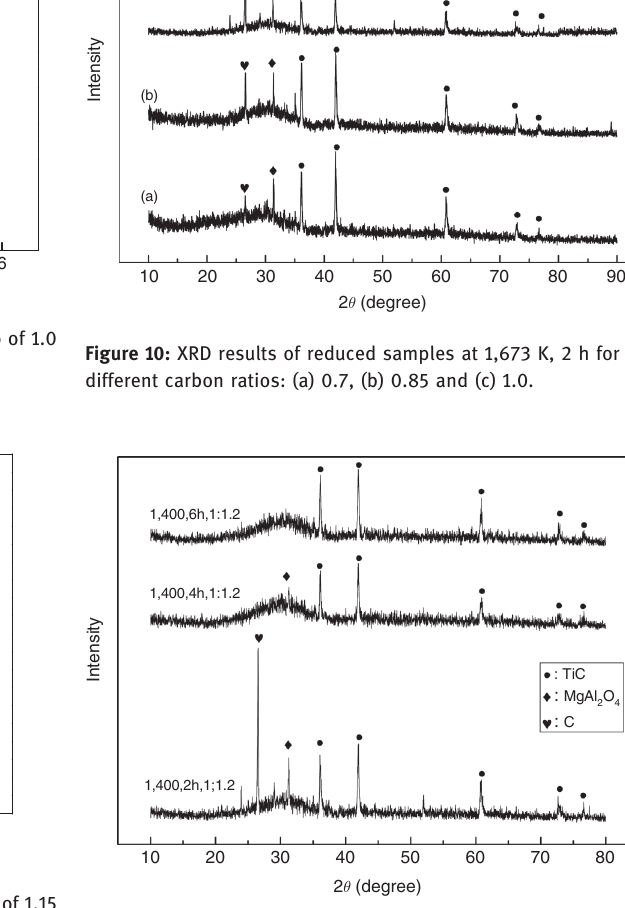
Figure 11: XRD results of reduced samples with carbon ratio of 1.0, at 1,673 K for different times: (a) 2 h, (b) 4 h and (c) 6 h.